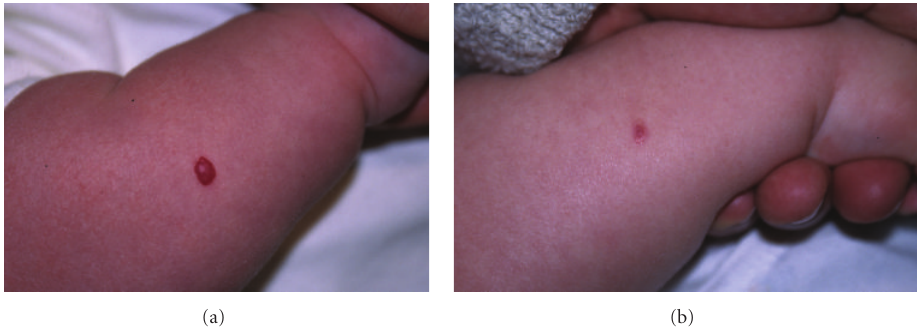
Figure 5: Infant 6 with haemangioma of the forearm, before and after 3 treatments with